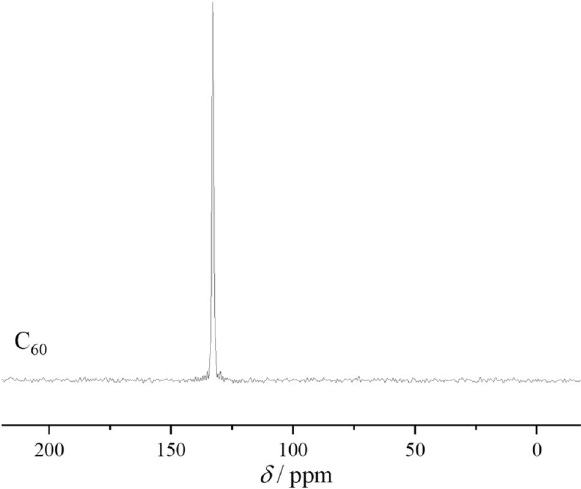
Figure 1. 13 C NMR spectrum of C 60 obtained with CP/MAS technique.